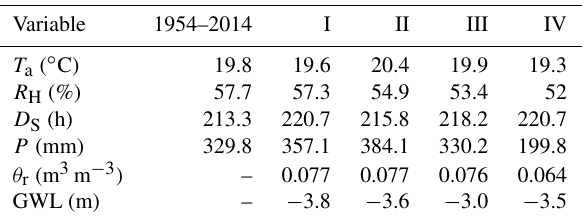
Table 1. Daily air temperature ( T a , ◦ C), relatively humidity ( R H